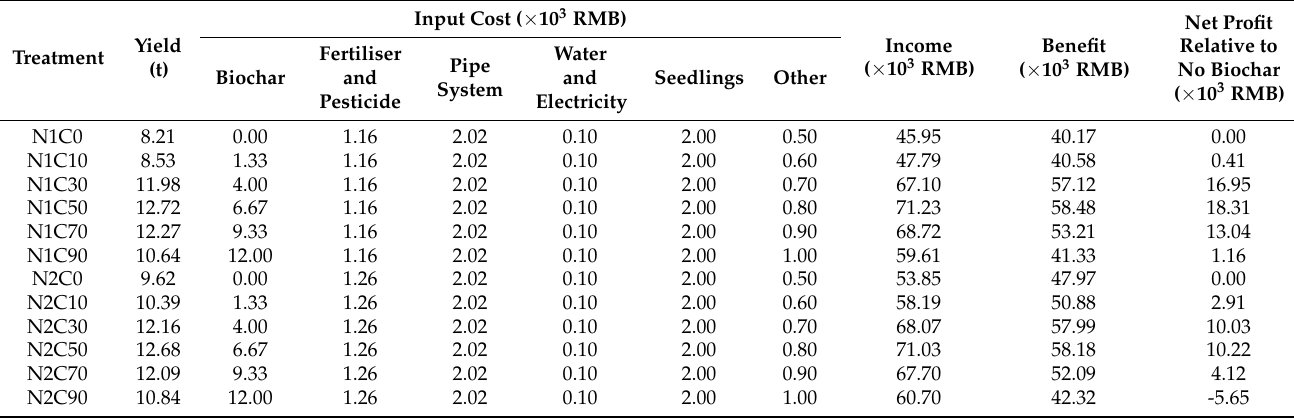
Table 3. A cost–benefit analysis for tomatoes grown with different biochar and N treatments in a single solar greenhouse.